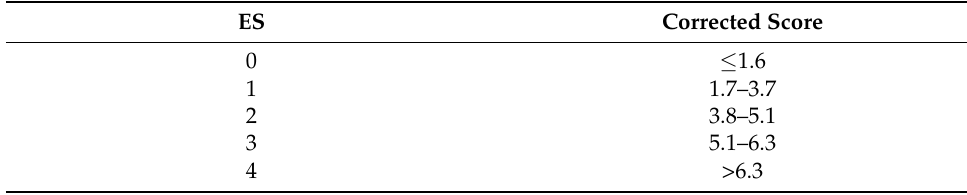
Table 6. Equivalent scores for corrected values of GVT accuracy.